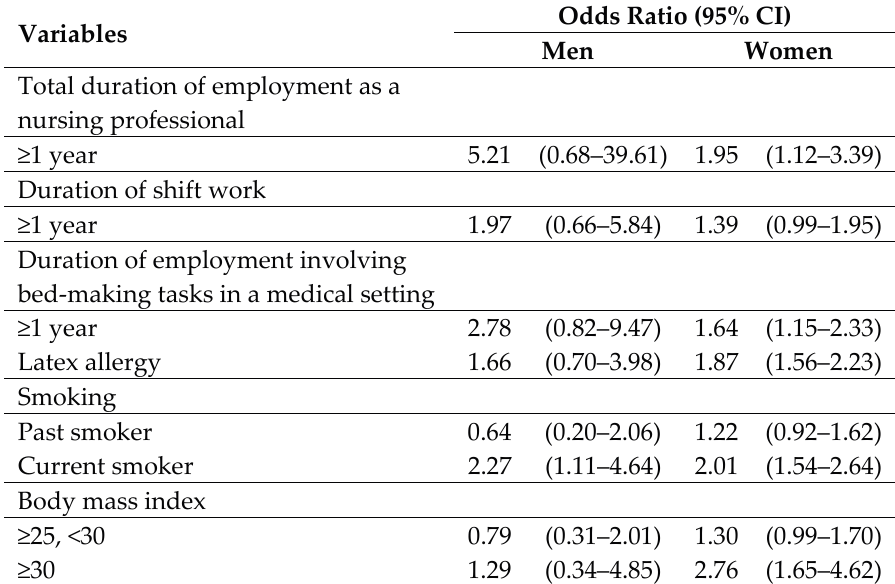
Table 7. Logistic regression analysis of the prevalence of